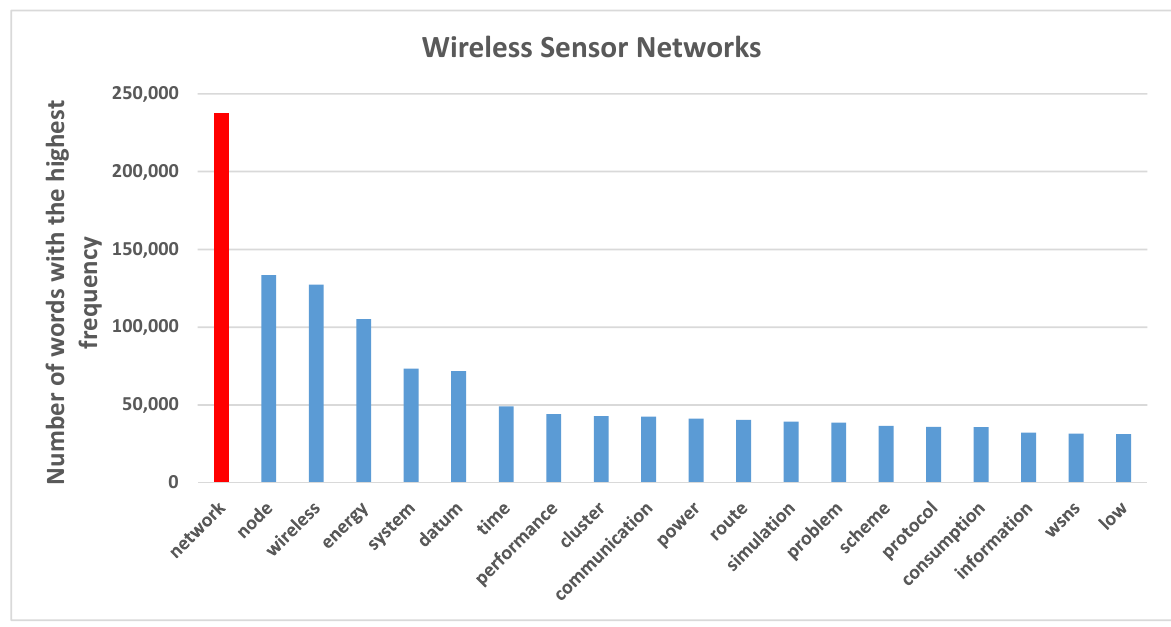
Figure 4. The highest frequent words in documents of wireless sensor networks.